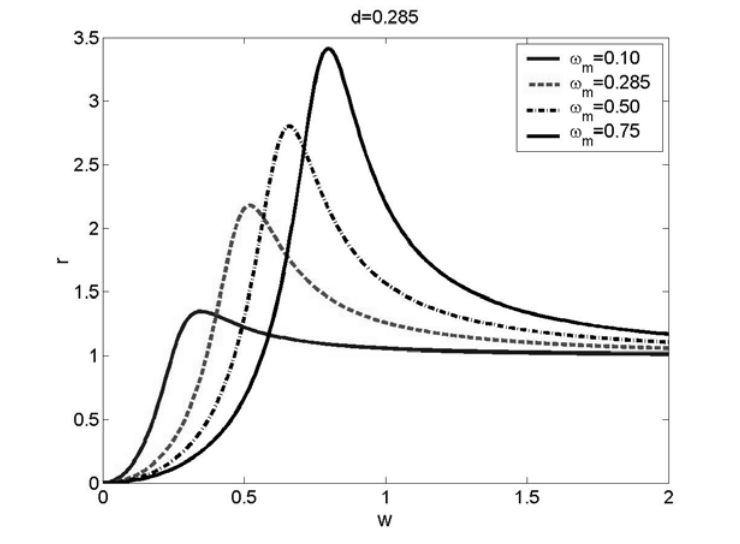
Fig. 13. Relative engine mass displacement.